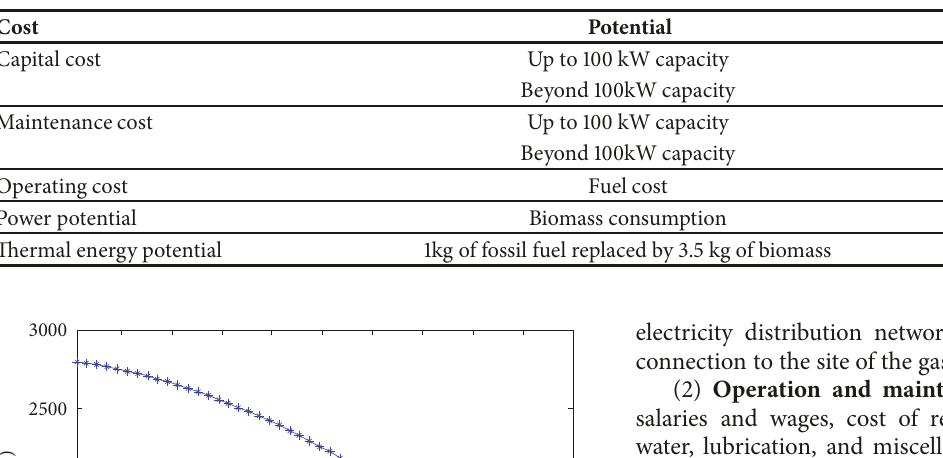
Table 11: Cost of building biomass gasification plant.